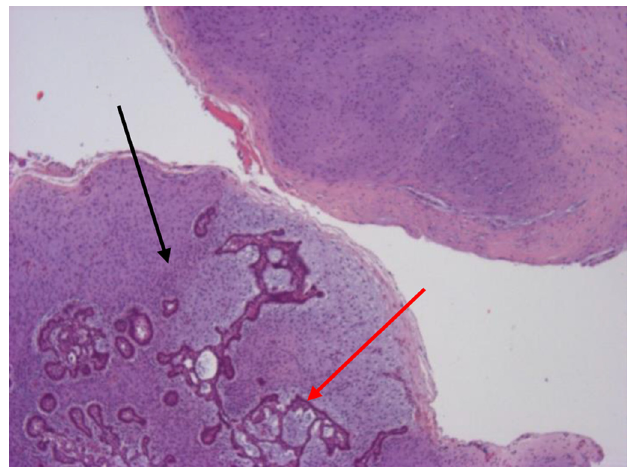
Fig. 5. Histological section. G (cid:1) 50: Ameloblastic fi bro-odontoma: Mesenchymal tissue (black arrow) with epithelial column (red arrow).